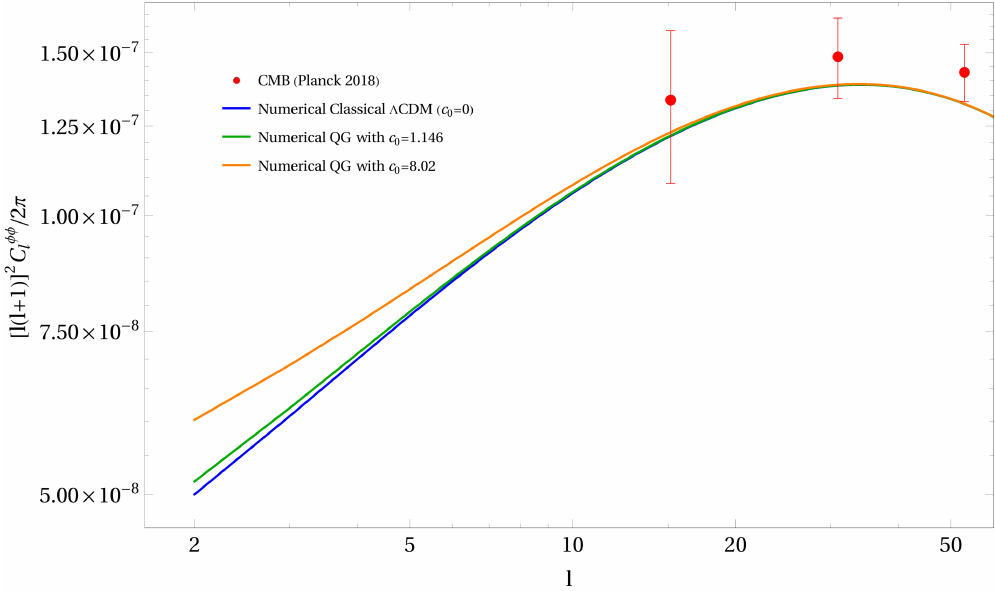
Figure 8. Comparison of the numerical prediction of the classical Λ CDM program vs. the numerical predictions of the RG running of Newton’s constant’s effect on the deflection lensing ( φφ ) power spectrum C φφ . The solid curves represent the numerical predictions generated by ISiTGR, with the l bottom (blue), middle (green) and top (orange) representing the quantum amplitudes (see Equation (9)) c 0 = 0,1.146,8.02, respectively, showing just slightly higher trends at the very large angular scales ( l < 5) as compared to the classical (no quantum running) numerical Λ CDM curve. Only limited observational data is available currently, especially at large angular scales (below l <